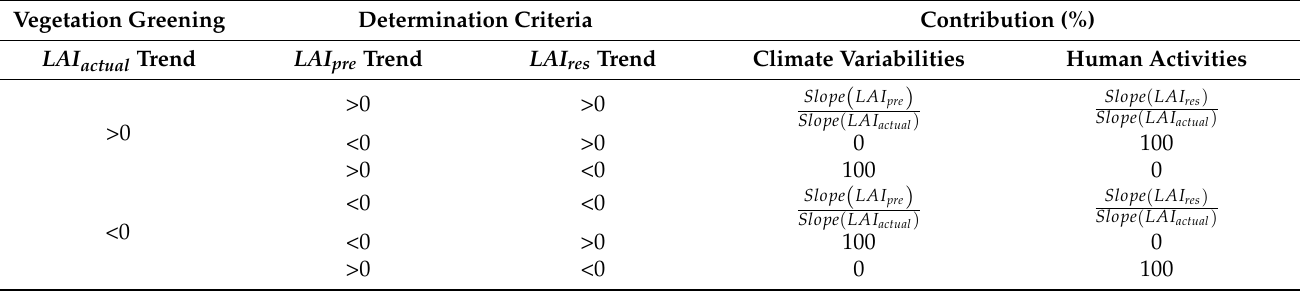
Table 1. Determination criteria of driving factors on vegetation greening and calculation methods of their contribution. Vegetation Greening Determination Criteria Contribution (%) LAI actual Trend LAI pre Trend LAI res Trend Climate Variabilities Human